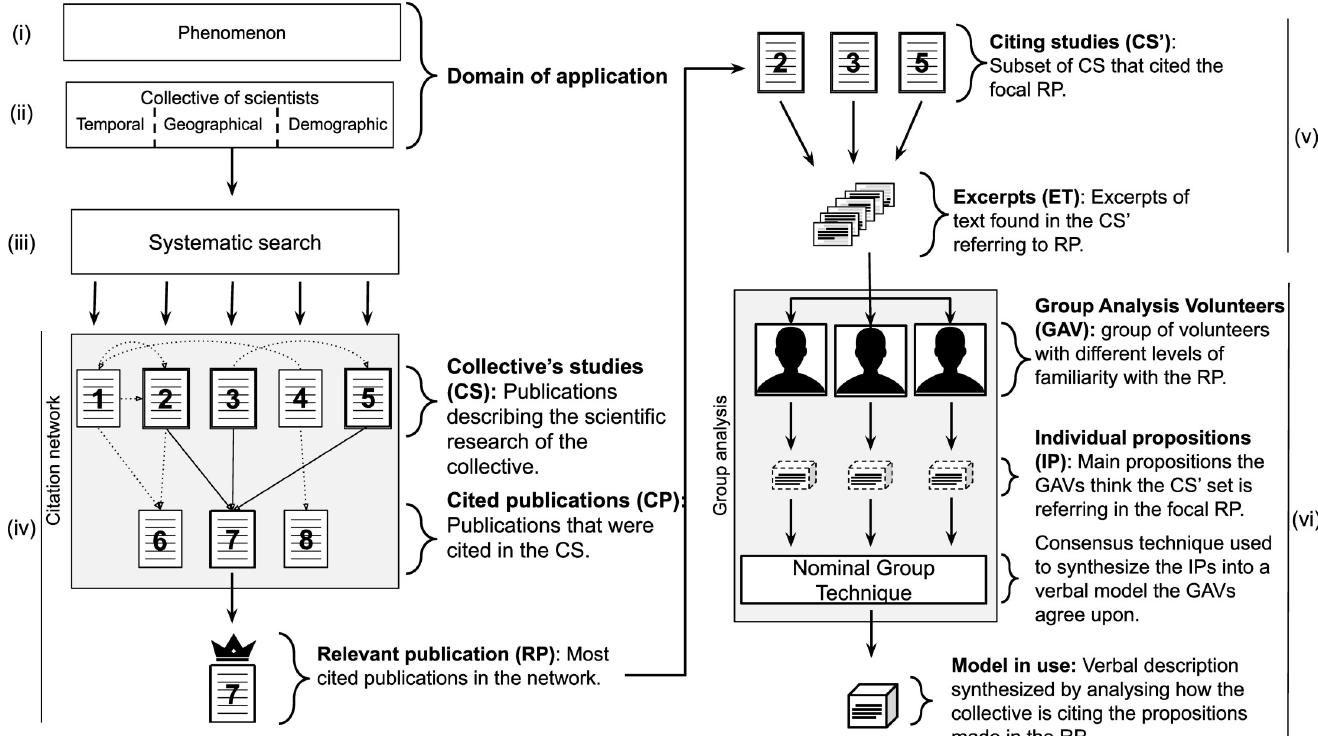
Fig 1. PATh workflow. Workflow depicting how the information obtained in each of the steps of the PATh (roman numerals) is used in the following step aiming to go from the definition of the domain of application to the final models in use. Note that the steps (v) and (vi) are carried out for each most referred publication in the set defined in step